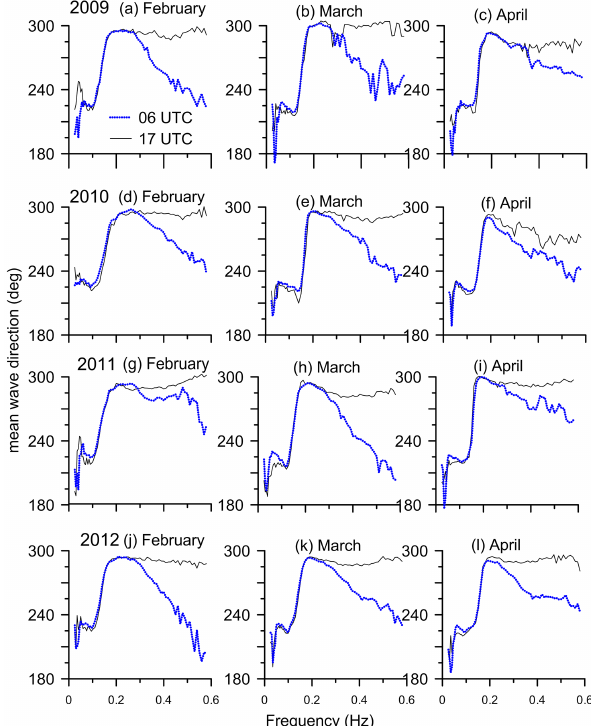
Figure 14. Monthly average mean wave direction during 06:00 and 17:00UTC from February to April in (a – c) 2009, (d – f) 2010, (g – i) 2011 and (j – l)